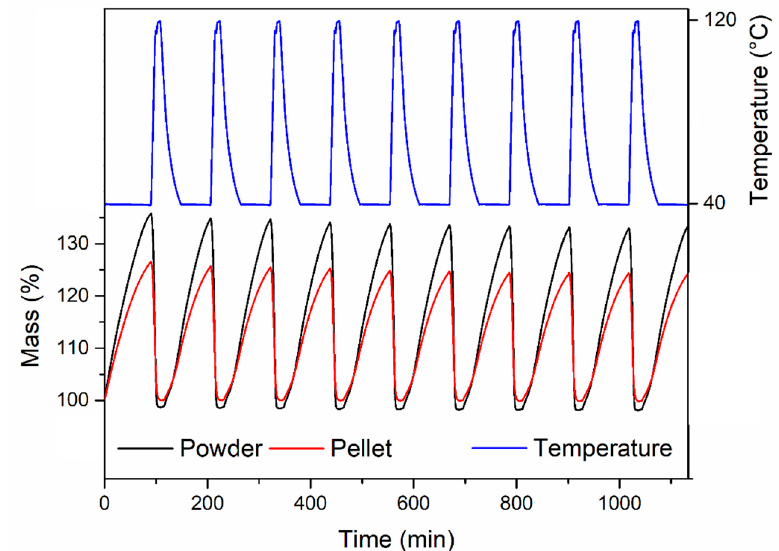
Figure 12. Cyclic H 2 O adsorption experiments for MOF-801 free-flowing powder (black) and the pellet containing 5 wt % PVB prepared by compressing for 15 s under 146 MPa pressure (red). The experiments were performed under 1 atm humidified air in adsorption and 1 atm Ar in desorption.